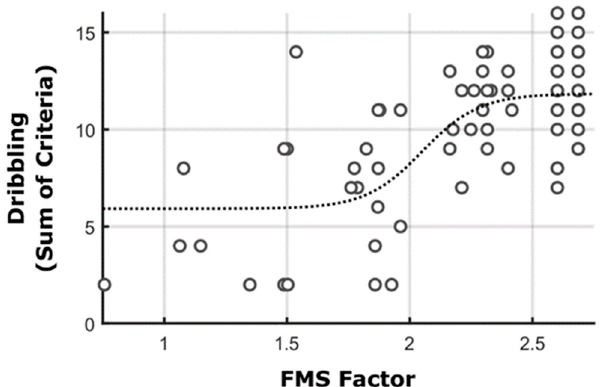
Figure 2. Relationship between the eigenvalues of the FMS factor found from Horn’s Parallel Analysis